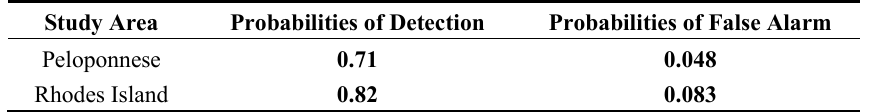
Table 2. Accuracy assessment results of the object-based burned area mapping using Advanced Land Observing Satellite (ALOS) Phased Array type L-band Synthetic Aperture Radar (PALSAR) images. The probabilities of detection (P ) are provided for the Peloponnese and Rhodes Island. alarm (P f